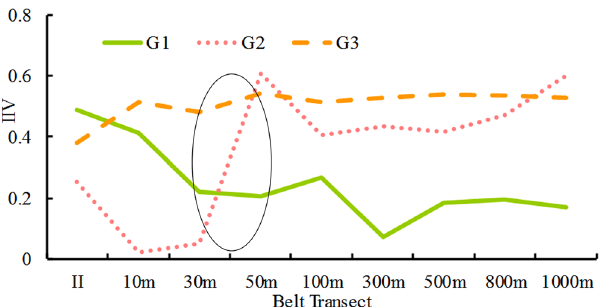
Figure 8. Changes in the IIVs of the three Clusters of plant species. The structure of plant communities in 30-m to 50-m belt transect area changed drastically, and became stable beyond 100-m belt